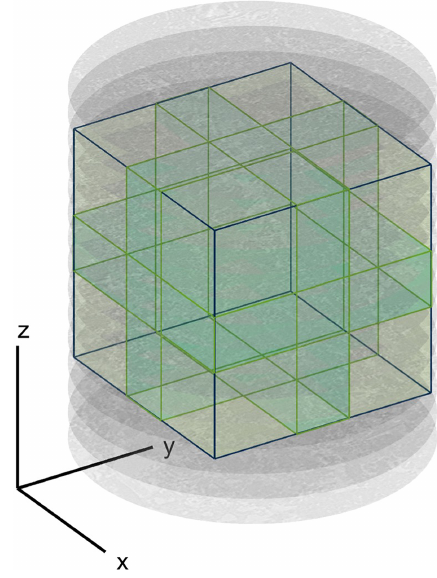
Figure 3. Sketch to illustrate the segmentation geometry (here for Carb-B; high resolution). The full cube is subdivided into eight partly intersecting subvolumes with a size of 400 3 grid points. Those subvolumes are used in the numerical simulations to estimate effective material